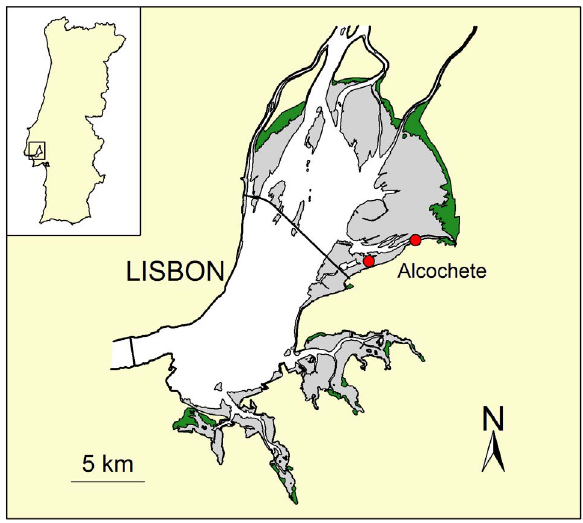
Figure 1. Map of the Tagus estuary, showing the location of the study area. Red dots represent the selected sectors of intertidal mudflat. Grey shading represent the intertidal area and green areas represent